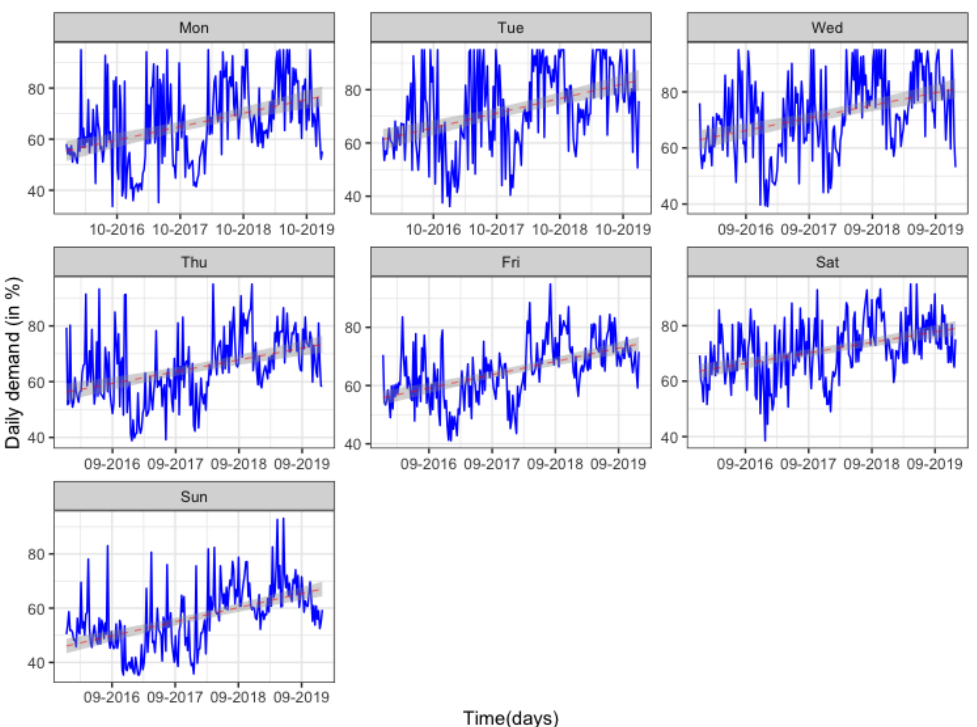
Figure 3. Day of the week demand for the entire data set. Figure 4 presents the correlation relationship among the dataset variables on each axis. The correlation values range from − 1 to +1. The relationship is also symmetrical and diagonal, which can be seen because the same two variables are matched mutually in those squares.